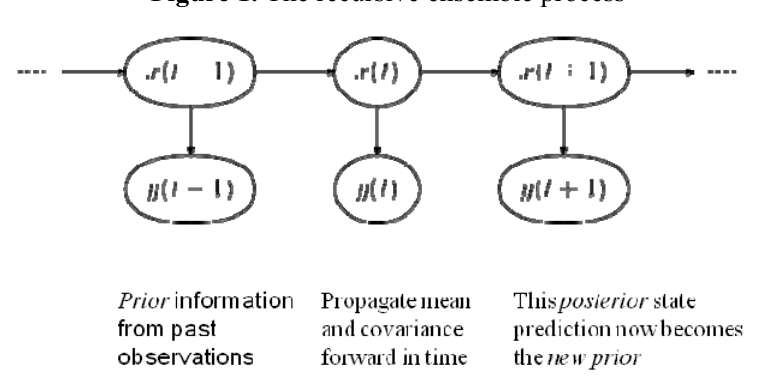
Figure 1. The recursive ensemble